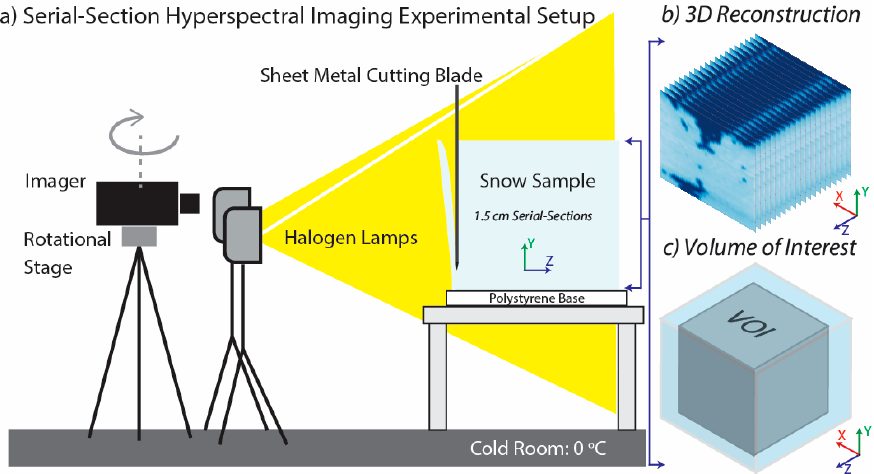
Figure 4. ( a ) Schematic of serial-section hyperspectral imaging experimental setup inside of cold room. ( b ) Visualization of a stack of serial-section images reconstructed to represent the 3D distribution of liquid water content in the snow sample. ( c ) Schematic of the entire volume of the reconstructed snow sample (light blue) and the volume of interest (VOI, gray) within the snow sample volume.